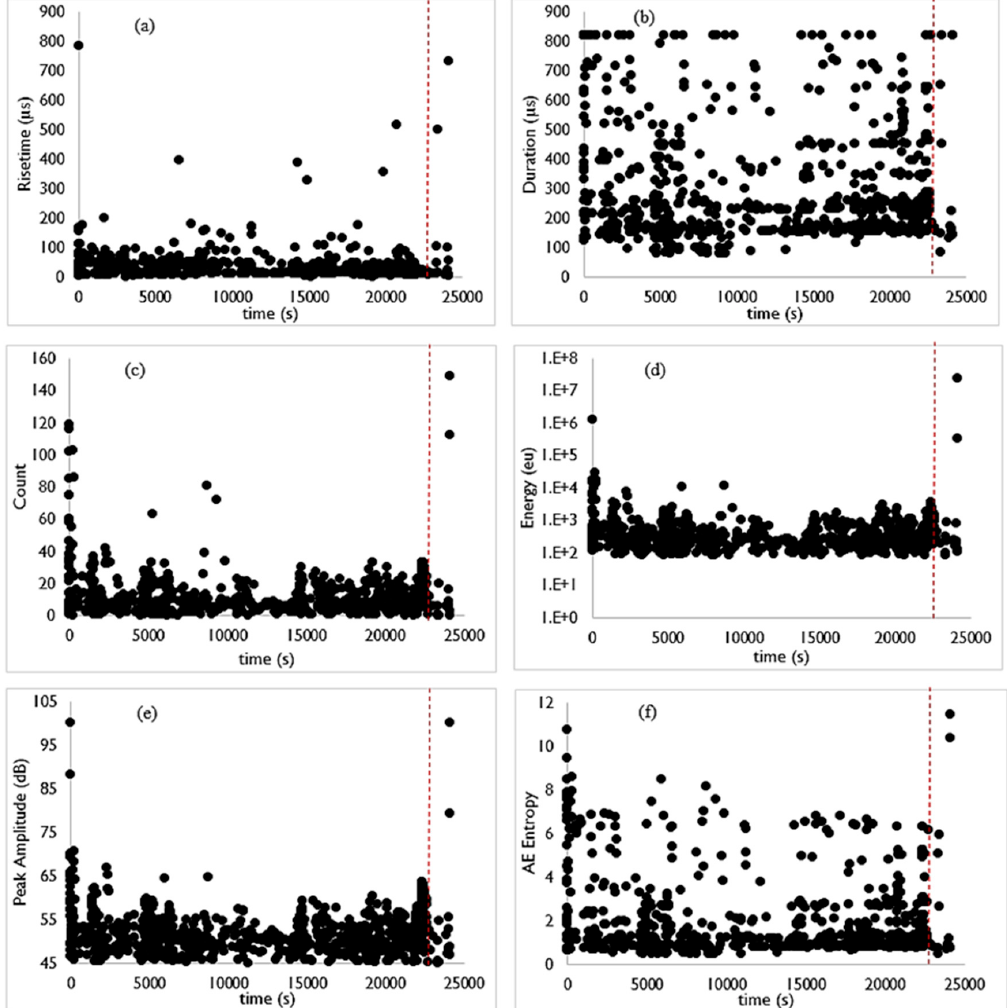
Figure 18. Variation of AE features for the fatigue specimen: ( a ) rise-time, ( b ) duration, ( c ) count, ( d ) energy, ( e ) peak amplitude and ( f ) AE entropy.